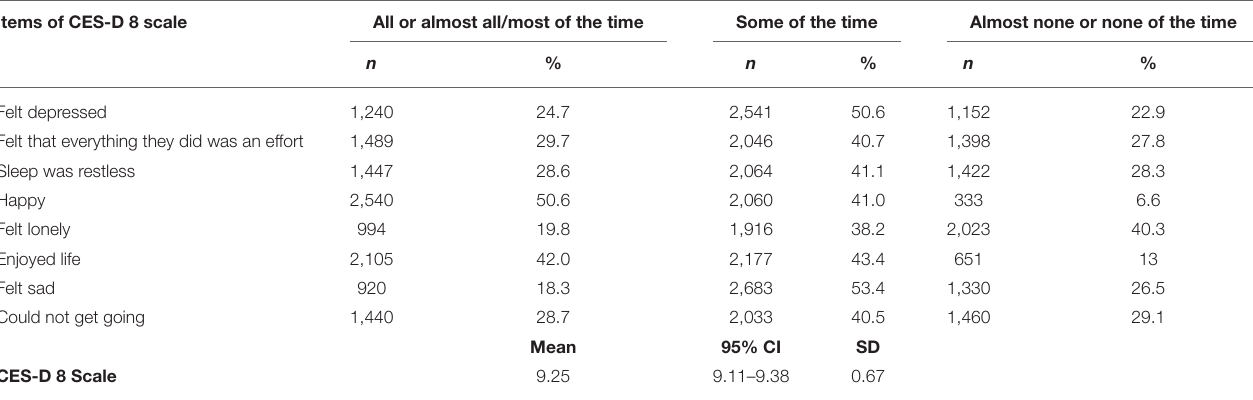
TABLE 2 | Description of subjective depressive symptoms during the outbreak of COVID-19 ( n = 4,933). Items of CES-D 8 scale